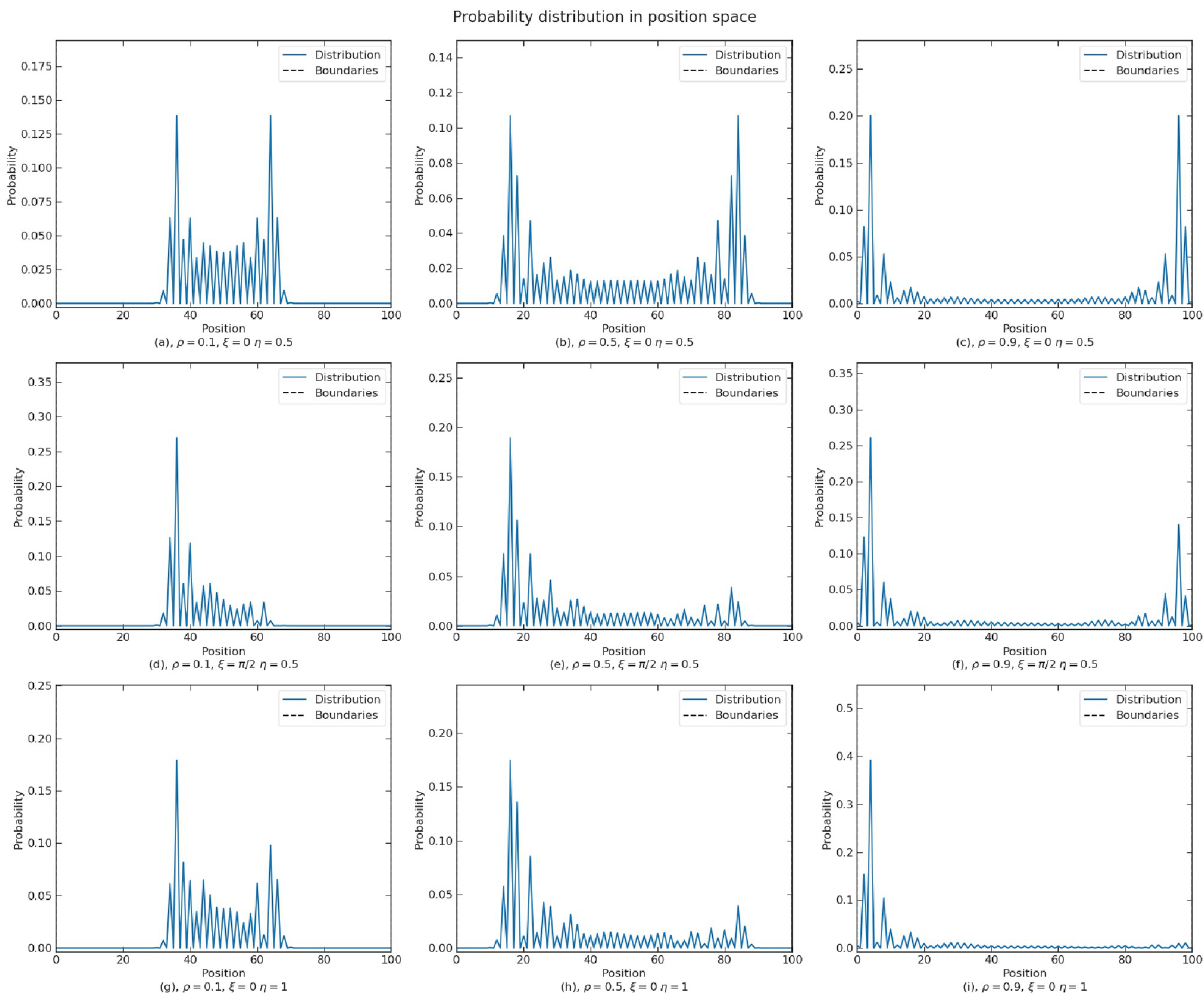
Fig 4. Influence of parameters ρ , ξ and η on the probability distribution of a walk in the position space at 50 time steps with no boundaries at both sides.